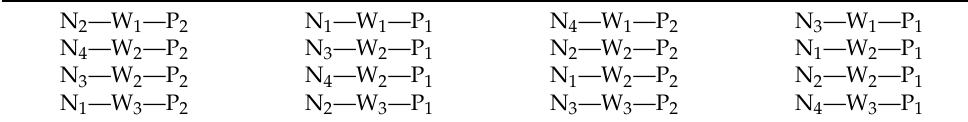
Table A1. Combination of different treatments.